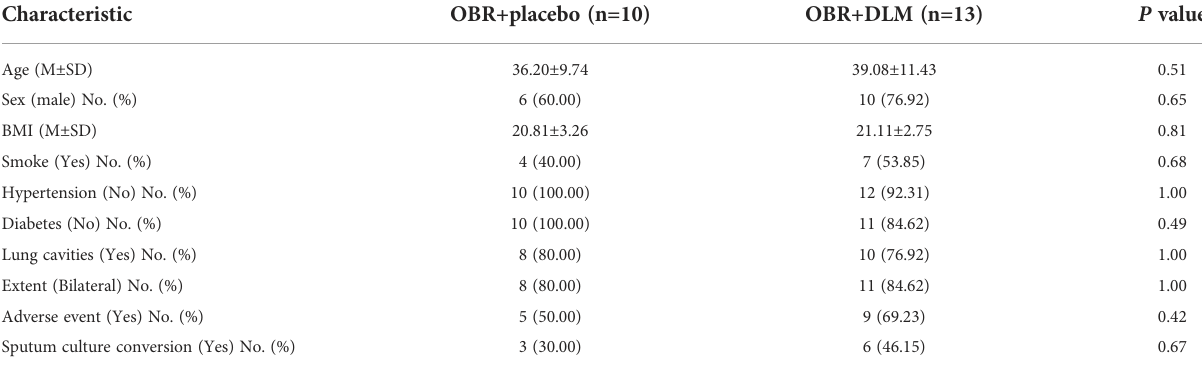
TABLE 1 Demographic and Baseline Clinical Characteristics.